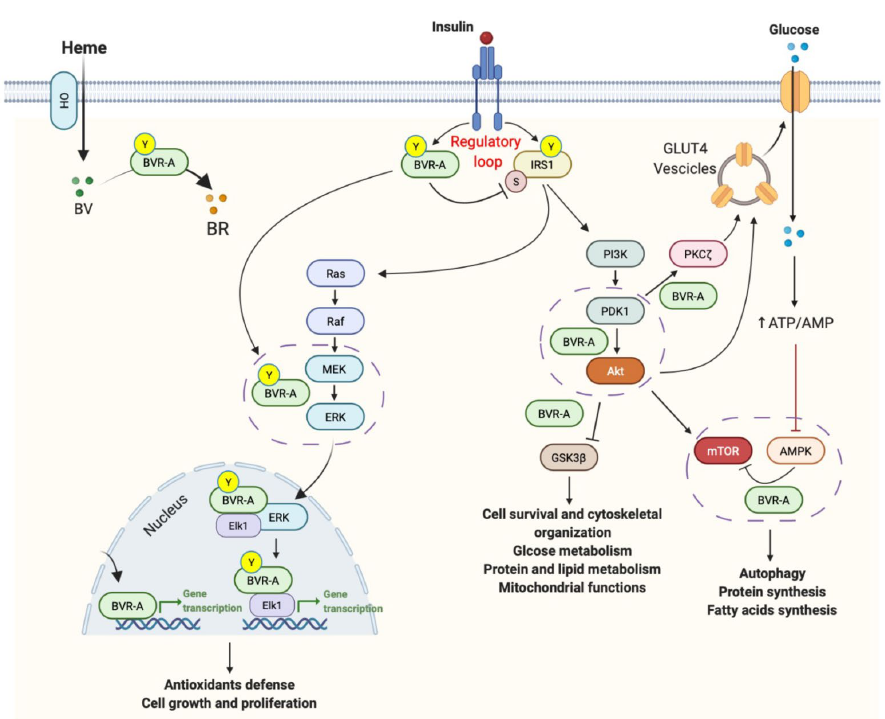
Figure 1. Known sites of BVR-A interaction in the insulin signaling pathway. Under physiological conditions, the activation of insulin signaling requires the binding of insulin to the insulin receptor (IR), which auto-phosphorylates on Tyr residues (Y, e.g., Tyr1158/1162/1163) and promotes the receptor tyrosine kinase-mediated phosphorylation of its substrate (IRS1) on specific Tyr residues (e.g., 632). In parallel, IR phosphorylates BVR-A on specific Tyr residues and activates BVR-A to function as Ser/Thr/Tyr kinase. Then, as part of a regulatory loop, BVR-A phosphorylates IRS1 on inhibitory Ser residues (S, e.g., Ser307) to avoid IRS1 aberrant activation in response to IR. Once activated, IRS1 works as a scaffold protein, driving the activation of the two main arms of the insulin signaling: (1) the Ras/Raf/MAPK pathway (ERK1/2) mainly involved in gene transcription; and (2) the PI3K/Akt axis that is critical for glucose uptake as well as for protein and lipid metabolism. Moreover, Akt promotes the phosphorylation of several targets, among which are: (1) GSK3β (on Ser9, inhibitory site), which has a role in energy production; and (2) mTOR (on Ser2448, activating site), which regulates protein synthesis and autophagy. Within both axes, BVR-A works as kinase or as scaffold protein facilitating: (1) ERK1/2 phosphorylation and the subsequent translocation in the nucleus and followed by the activation of Elk1; (2) the PDK1-mediated activation of Akt; (3) PDK1-mediated activation of the atypical PKC ζ ; (4) the Akt- mediated inhibition of GSK3β. Moreover, BVR-A was found to be essential for the AMPK-mediated inhibition of mTOR. Under condition of energy depletion, AMPK directly senses increases in AMP:ATP and ADP:ATP ratios, thus promoting the inhibition of mTOR to block the processes that deplete cellular ATP (e.g., protein synthesis and cell cycle progression, controlling cell size and preventing apoptosis). Moreover, AMPK is activated in response to nitrosative stress and that occurs independently of AMP/ATP levels. Conversely, reduced AMPK activation leads to mTOR hyper-activation. Arrows represent stimulation; lines represent inhibition. See text for more details.